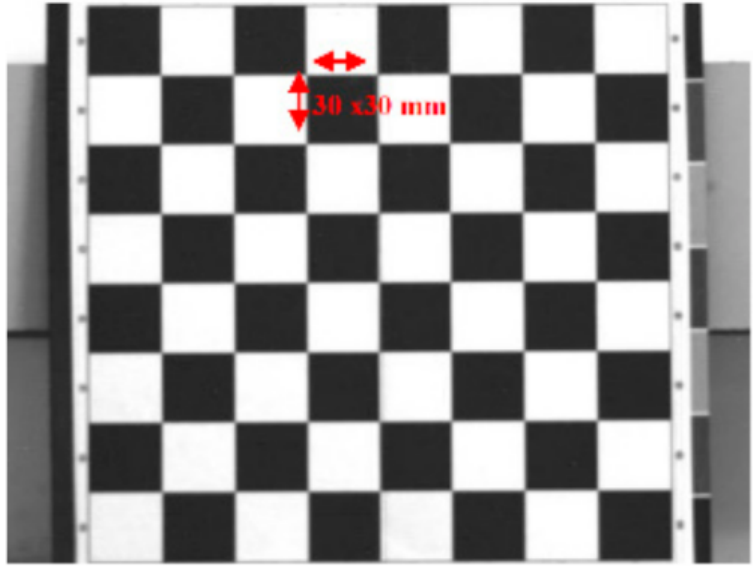
Figure 31. Scaling factor from calibrated camera